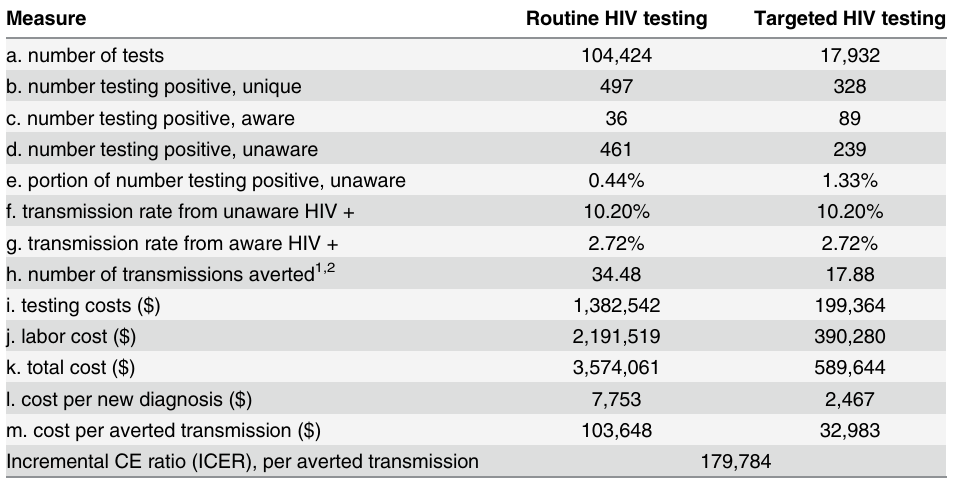
Table 3. Cost Effectiveness of Routine and Targeted HIV Testing, Washington, DC,